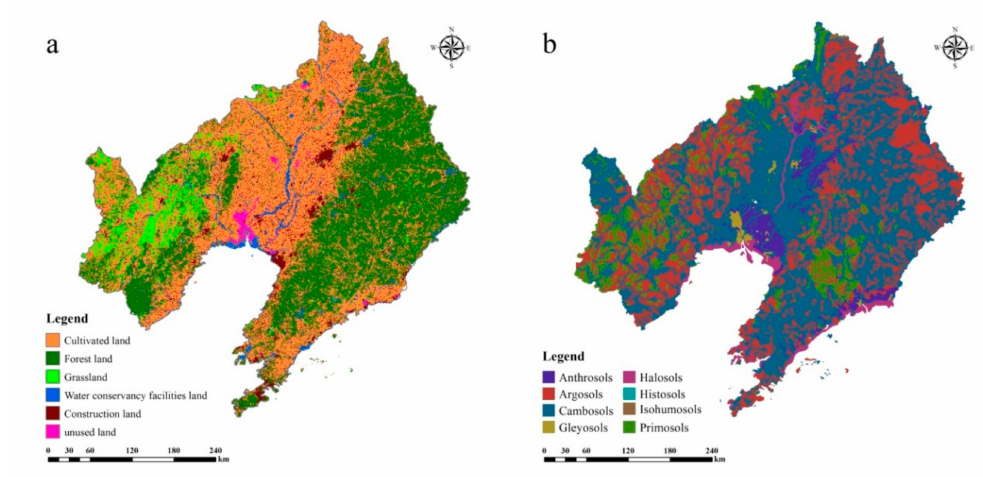
Figure 2. Land use types ( a ) and soil types ( b ) in the study